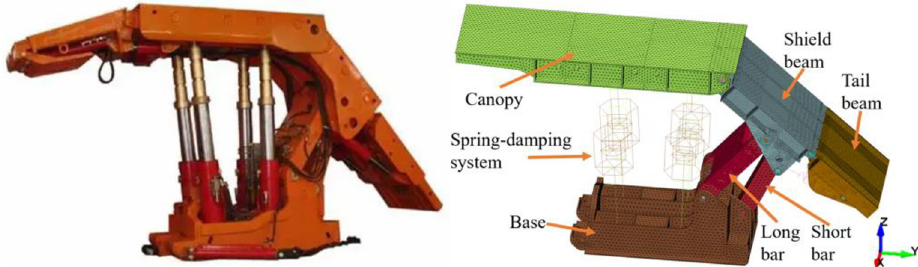
Fig 3. The hydraulic support. For physical device (left) and finite element model